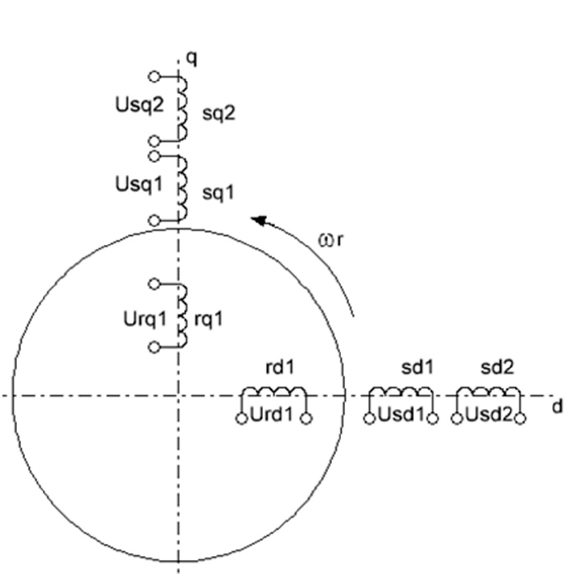
Figure 6. Electric circuit of a single-phase higher-capacity generator.